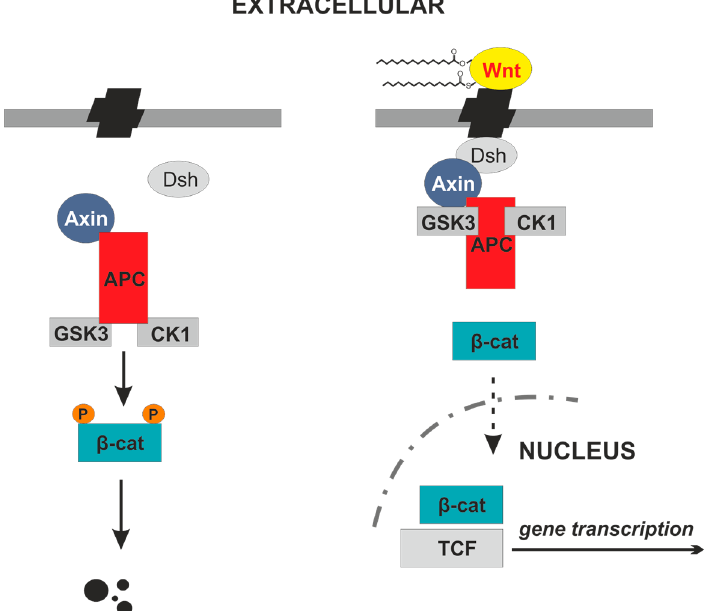
Figure 1. Scheme of canonical wingless (Wnt) protein signaling. ( Left ) In the absence of activated Wnt phosphorylation of β -catenin protein by a protein-kinase complex is found resulting in degradation of β -catenin; ( Right ) After coupling of activated Wnt to Fzd the protein-kinase complex is translocated and accumulation of β -catenin is found. The active β -catenin protein translocates into the nucleus and activates gene transcription via T cell factor (TCF) binding.